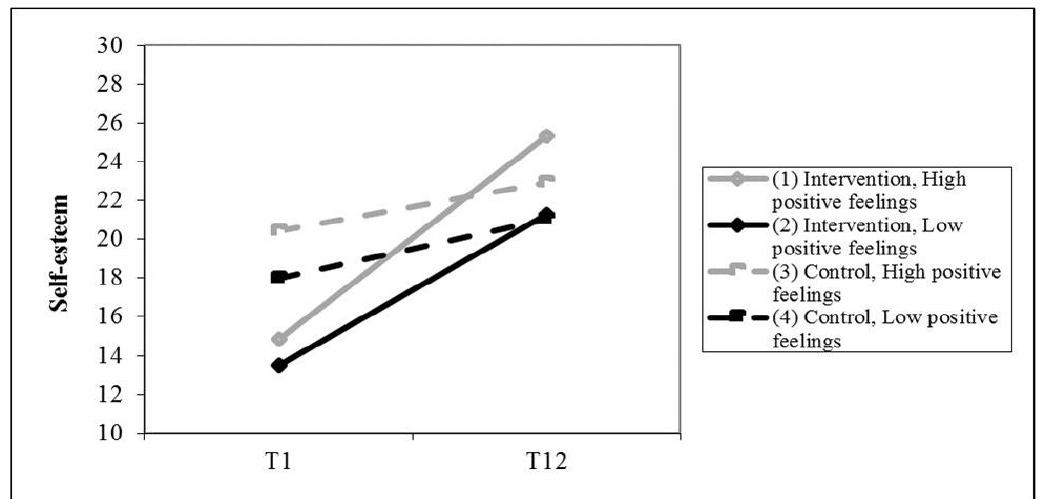
Figure 3. Correlation between positive feelings during the session, and change in self-esteem as a function of group. Table 4. HLM coefficients and their significance for assessing correlations between the working alliance, positive feelings, and meaning of the session indices, and the change in self-esteem as a function of group.